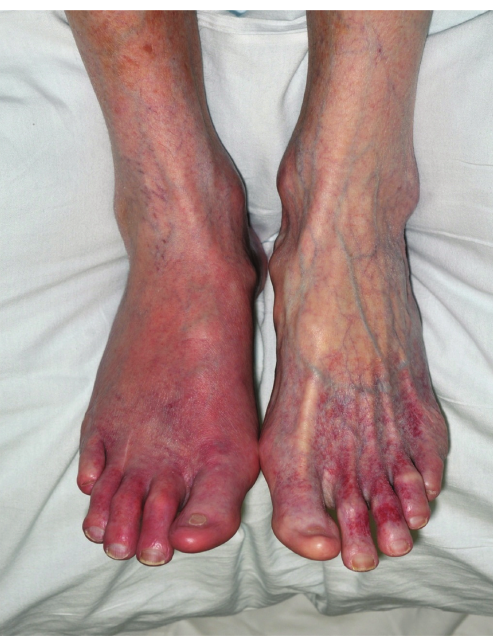
Figure 2: 24 hours after treatment with